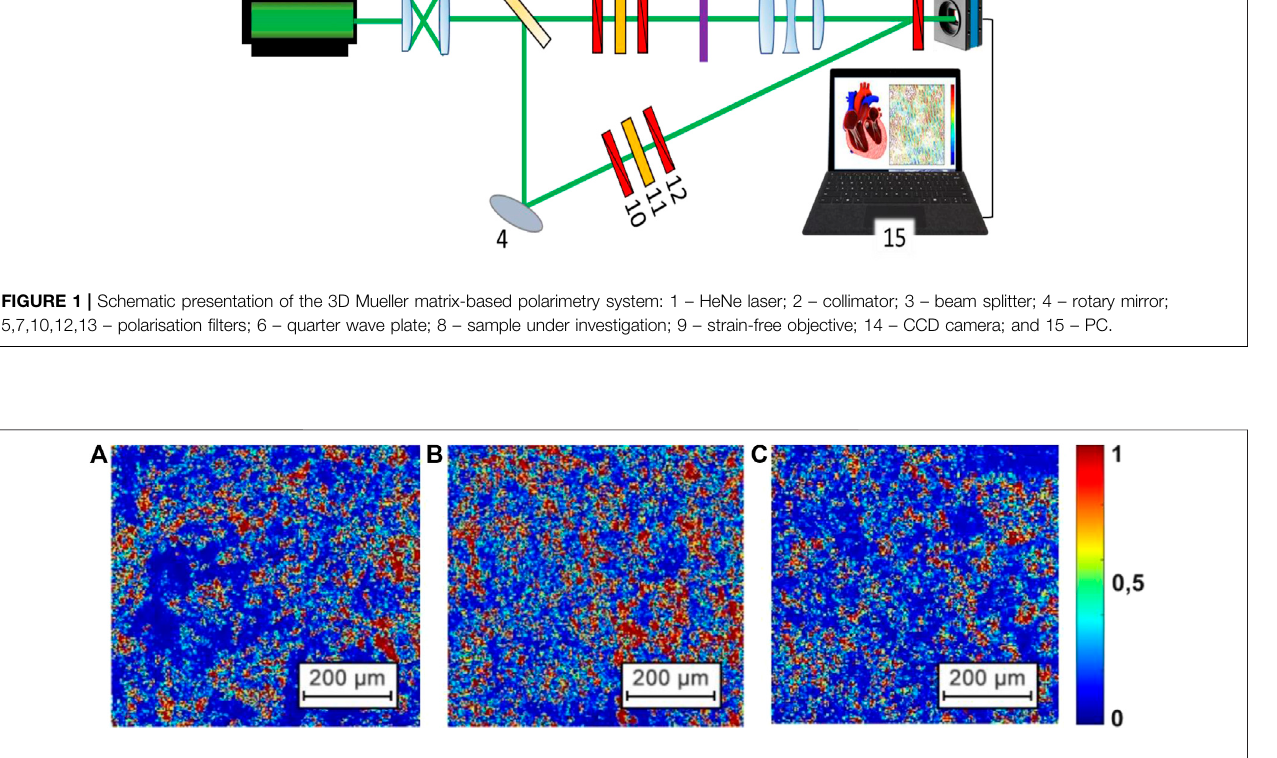
FIGURE2| TheexamplesoforiginalCCDdetected imagesofsamplesofhistologicalsectionsofthemyocardiumfromGroup1 (A) ,Group2 (B) ,andGroup3 (C) .